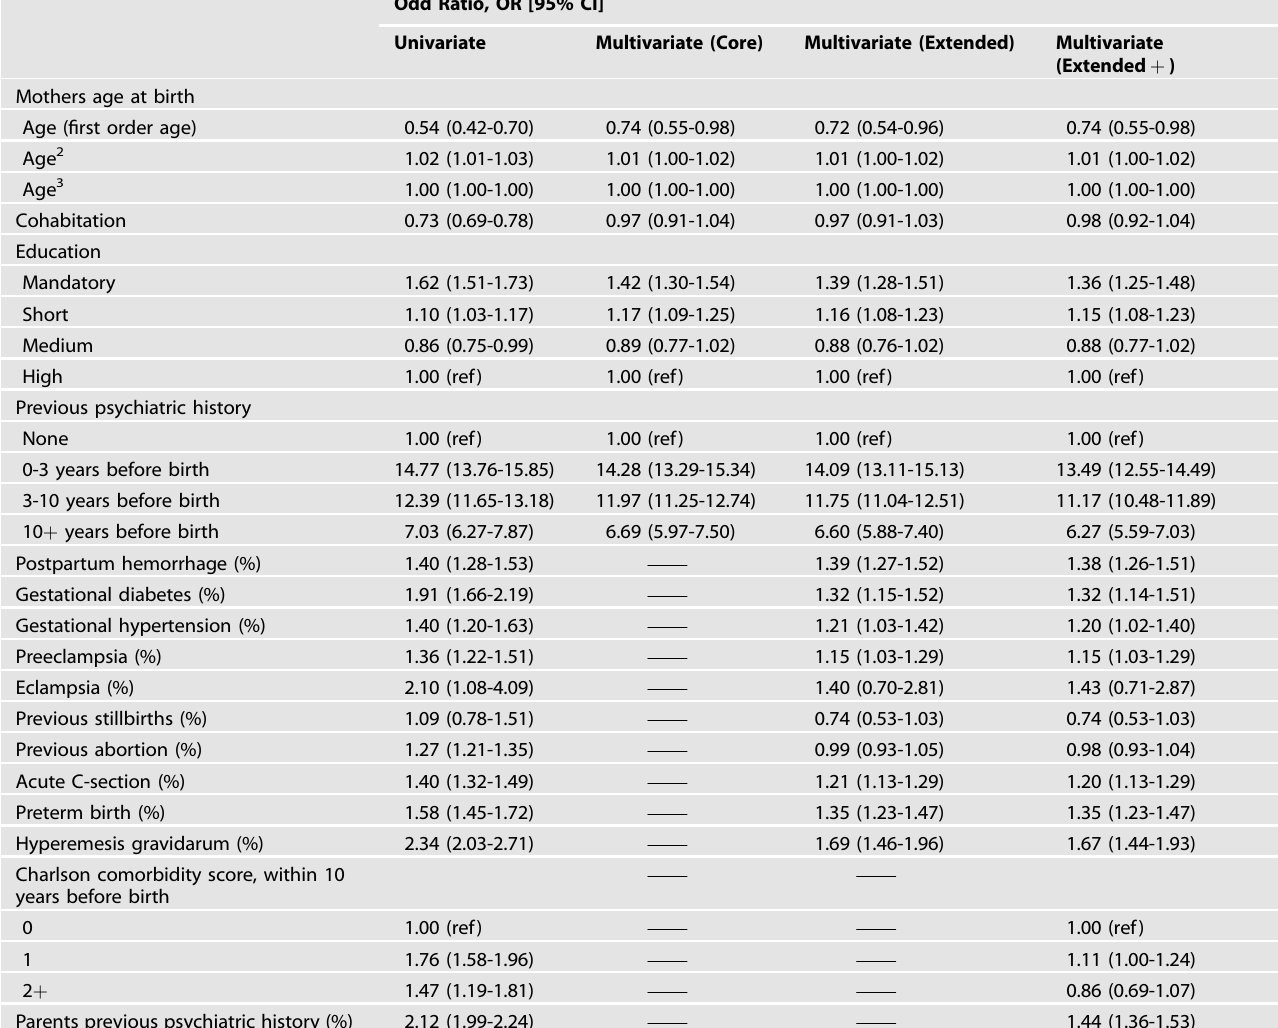
Table 2. Odds ratios (crude and mutually adjusted) between predictor variables and PPD within 6 months after